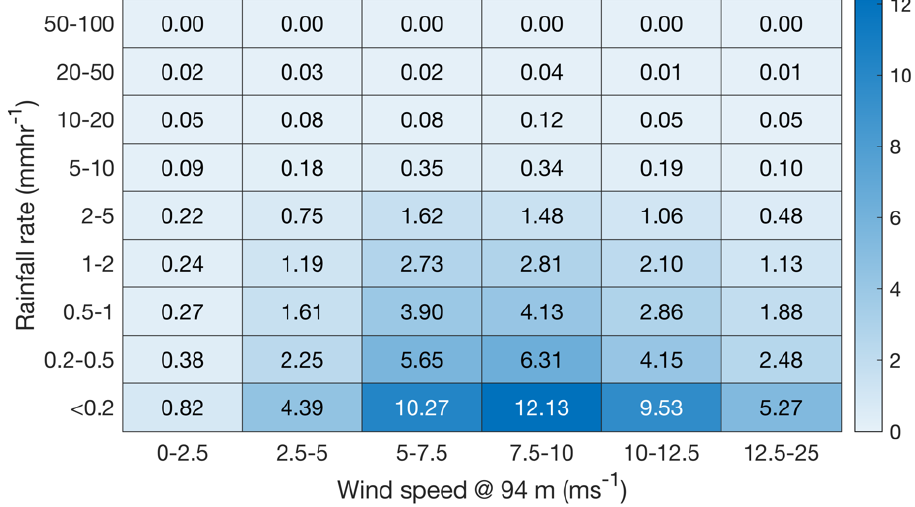
Figure 13. Heatmaps of the joint probabilities (in %, colorbar and also numeric values shown in each cell) of RR and wind speeds at onshore Denmark. The joint probabilities are computed for periods with liquid precipitation.